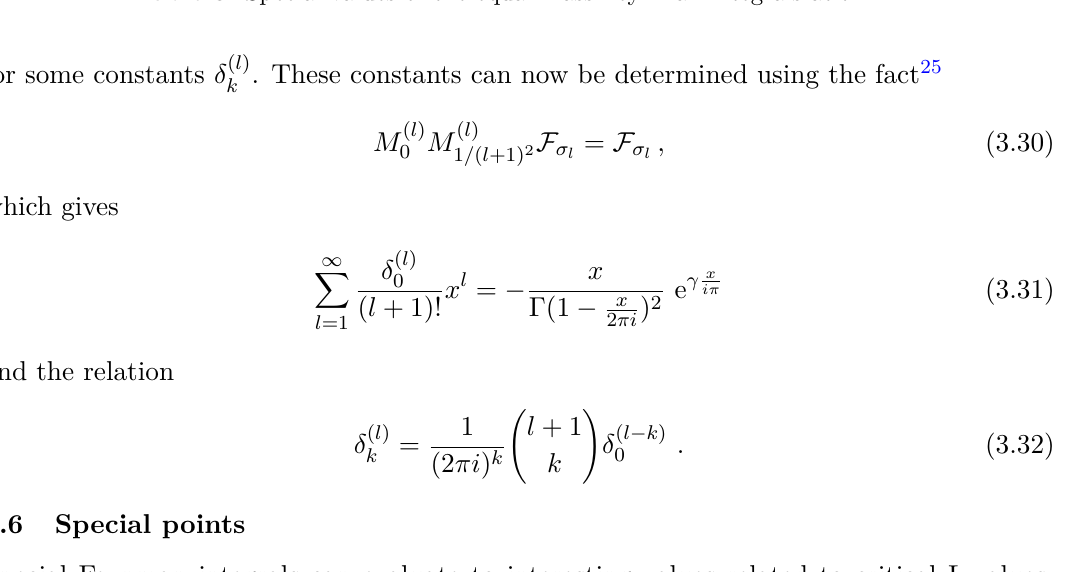
Table 3 . Special values of the equal mass Feynman integrals at t = 1